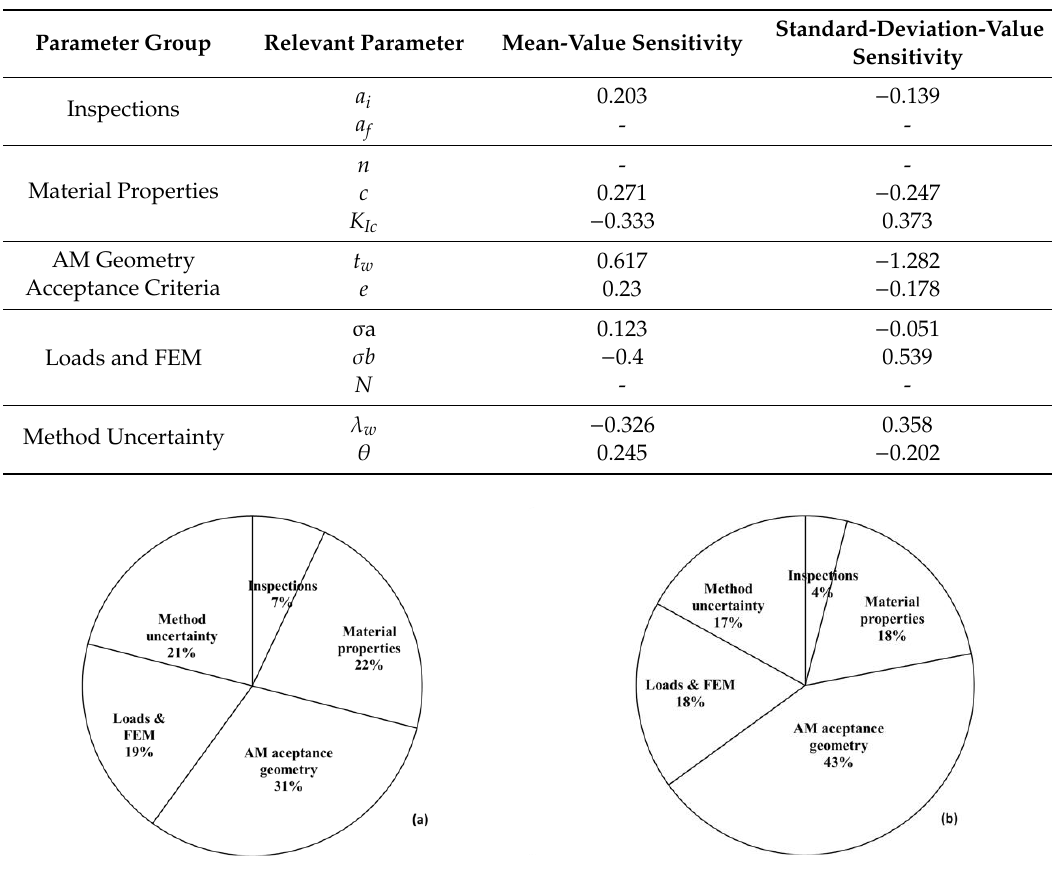
Figure 6. Parameters weight in AM-component reliability. PDF mean ( a ) and standard deviation ( b ) values.